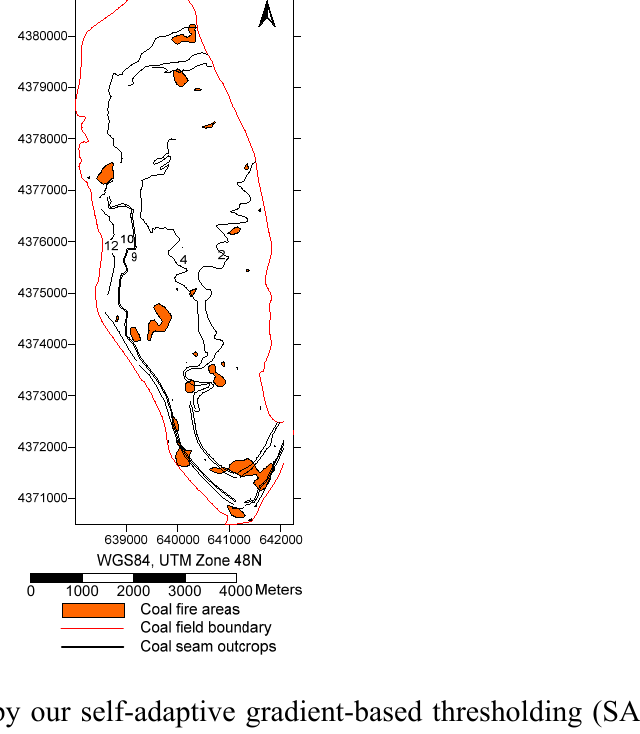
Figure 4. Coal fires extracted by our self-adaptive gradient-based thresholding (SAGBT) method mapped with coal seam outcrops. Orange areas indicate daytime coal fires for 27 March 2013. Black lines are coal seam